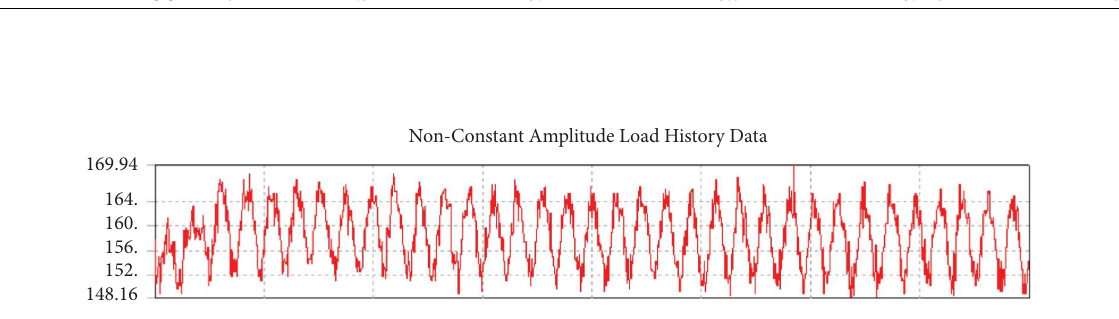
Figure 17: Power supply initial conditions of Workbench simulation